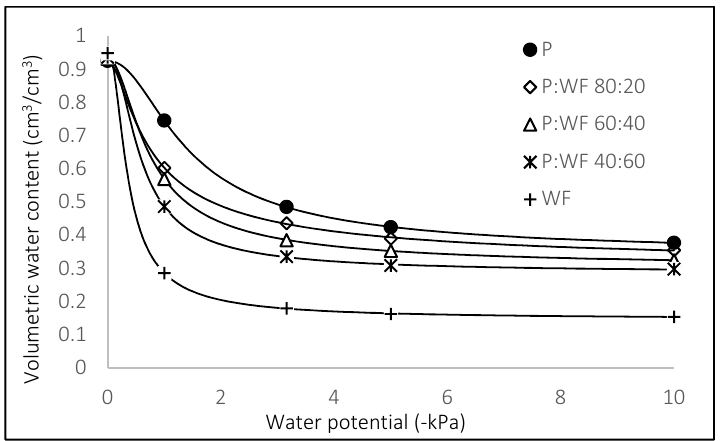
Figure 4. Water retention curves fitted according to the Van Genuchten [18] model from data obtained by suction table for peat (P), wood fiber (WF) and peat:wood fiber mixes (P:WF). Table 4. Main physical properties calculated for peat, wood fiber and mixes peat:wood fiber from water retention curves. Water Holding Capac- Available Water ity (WHC) b (AW) b